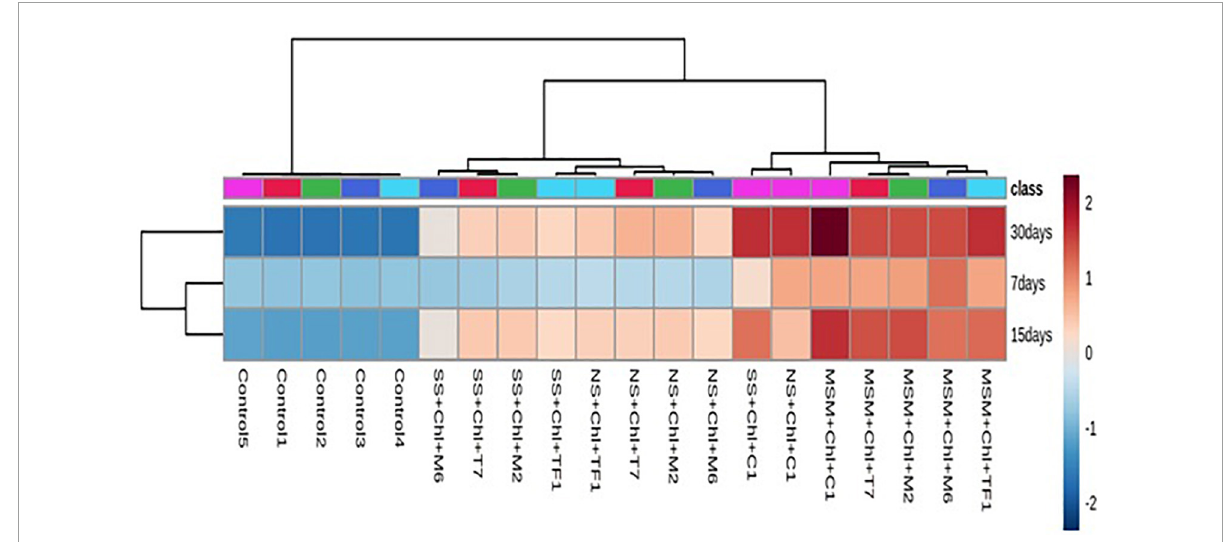
FIGURE5 Heat map analysis of chlorpyrifos biodegradation by individual strains and developed consortium (ERM C-1) at different time intervals.